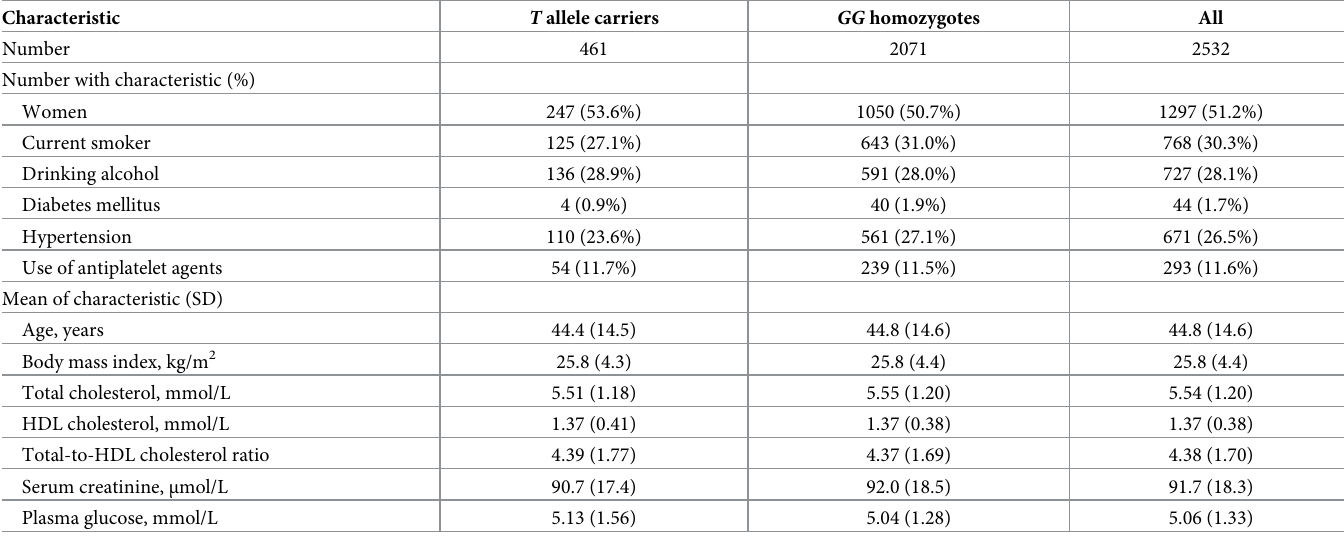
Table 1. Characteristics of participants at enrolment by rs12566888 genotype (1985–2007).